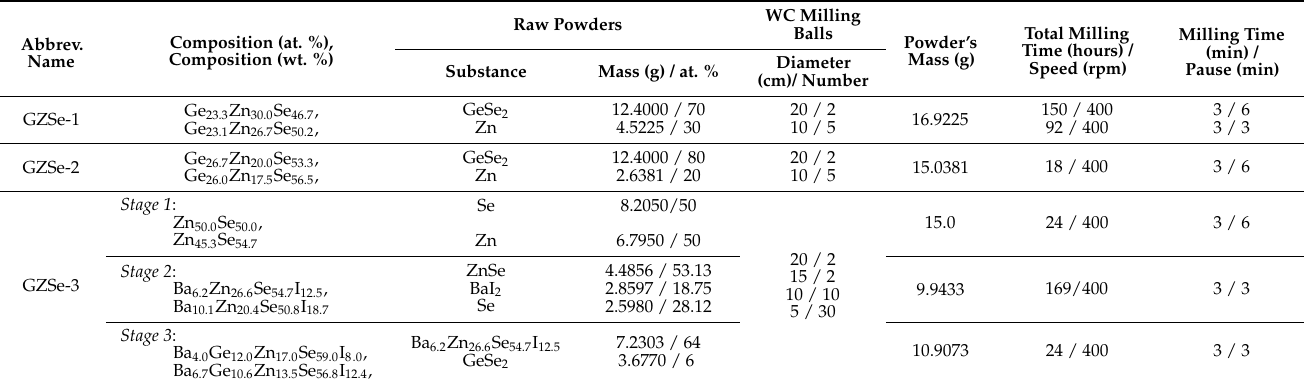
Table 1. The mechanical alloying synthesis parameters of the glass-ceramics compositions. The total milling time includes the